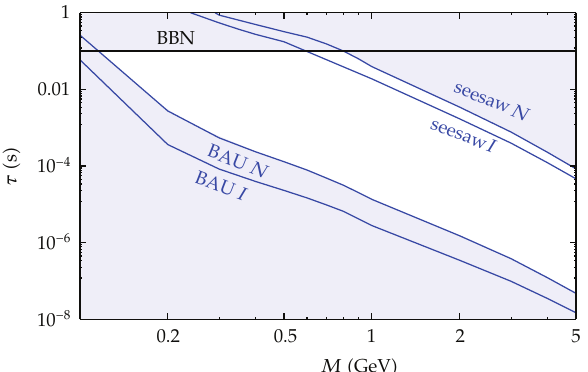
Figure 5: Constraints on the sterile neutrino lifetime τ N coming from the baryon asymmetry of the Universe (cid:2) blue solid lines: “BAU N ” refers to the normal hierarchy, “BAU I ” refers to the inverted hierarchy (cid:3) , from the seesaw mechanism (cid:2) blue solid lines: “Seesaw N ” refers to normal hierarchy, “Seesaw I ” refers to the inverted hierarchy (cid:3) and big bang nucleosynthesis (cid:2) black line: “BBN” (cid:3) . The allowed region of parameter space is in white. Limits from direct searches presented in Figure 4 are not